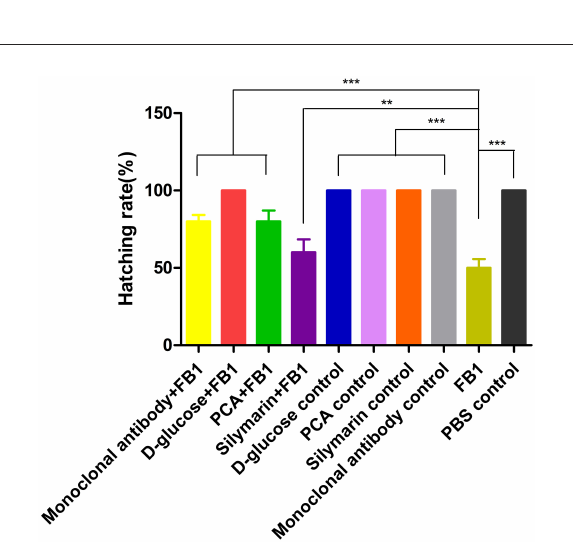
FIGURE4 Hatching rate post FB1-treated with anti-FB1 monoclonal antibodies, or D-glucose, PCA, or silymarin. All control groups yielded 100%, while 80%, 70%, and 60% of the hatching rate were found in the PCA-treated group, anti-FB1 monoclonal antibody-treated group, and the silymarin-treated group, respectively. Compared to the FB1 group and the silymarin + FB1 group, a higher hatching rate was determined in the PCA-treated group and the anti-FB1 monoclonal antibody-treated group. ** p < 0.01 and *** p < 0.001.